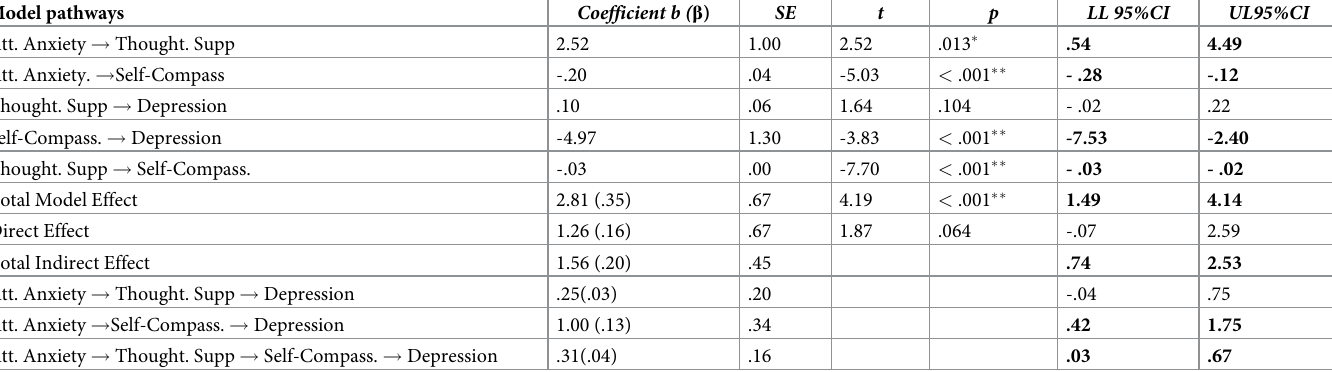
Table 3. Serial mediation effects of thought suppression and self-compassion on the relationship between attachment anxiety and depression whilst controlling for attachment avoidance (Model B). Model